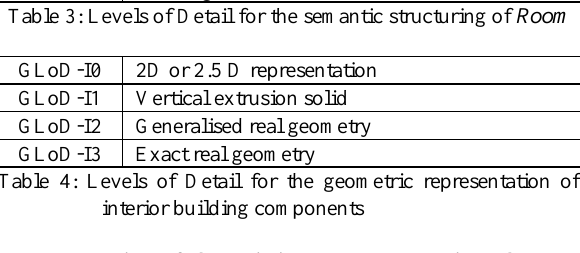
Table 3: Levels of Detail for the semantic structuring of Room